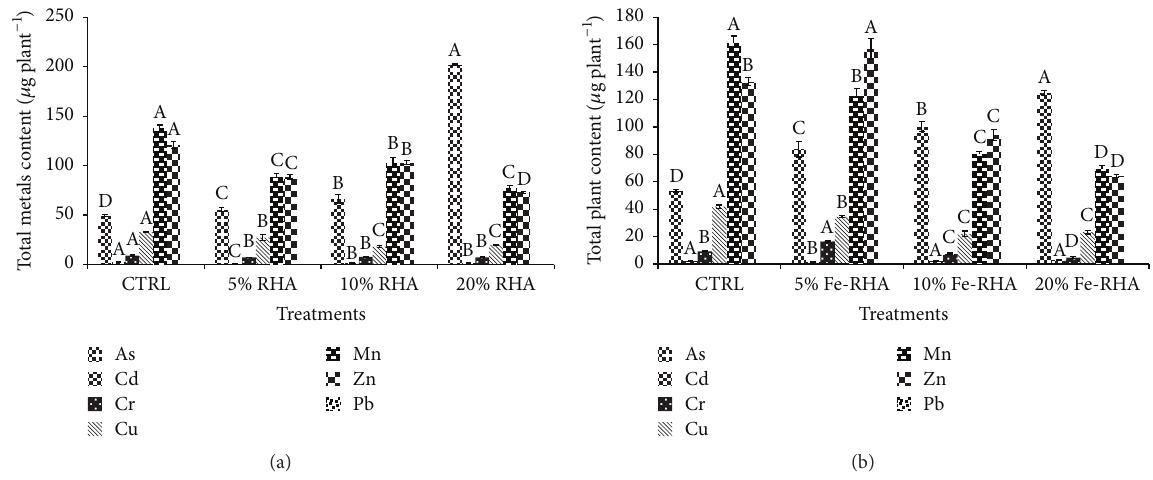
Figure 8: Total As, Cd, Cr, Cu, Mn, Zn, and Pb uptake ( 𝜇 g plant −1 ) by vetiver grass grown in gold mine amended with Fe-RHA and RHA (mean 𝑛 = 3 , ± SD). Different letters correspond to significant differences between rates of the same ash ( 𝑃 < 0.05 ). Pb was not detected.